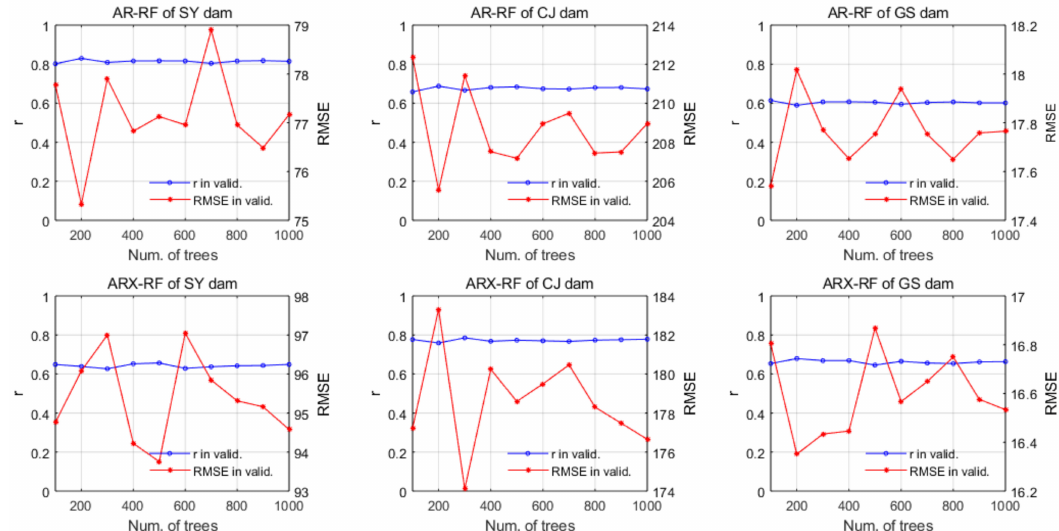
Figure 10. Correlation coefficients (r) and root mean square error (RMSE) of the AR-RF and ARX-RF models according to the number of trees in the validation period for the SY, CJ, and GS dams. The blue line is the r-value in the validation period and the red line is the RMSE in the validation period. Table 8. The optimal number of trees of the AR-RF and ARX-RF models for the three dams.